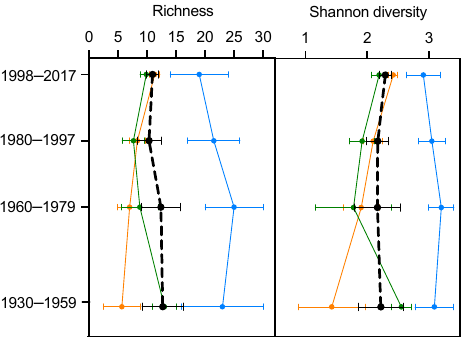
Figure 1. Alpha diversity measures (mean Richness and Shannon diversity index ± SE) of metazoan communities through time in seagrass meadows ( H. stipulacea in green; C. nodosa in orange; P. oceanica in blue; overall of the three seagrass species in black). Dashed dark lines indicate non-significant differences between time intervals, considering the three seagrass species combined.